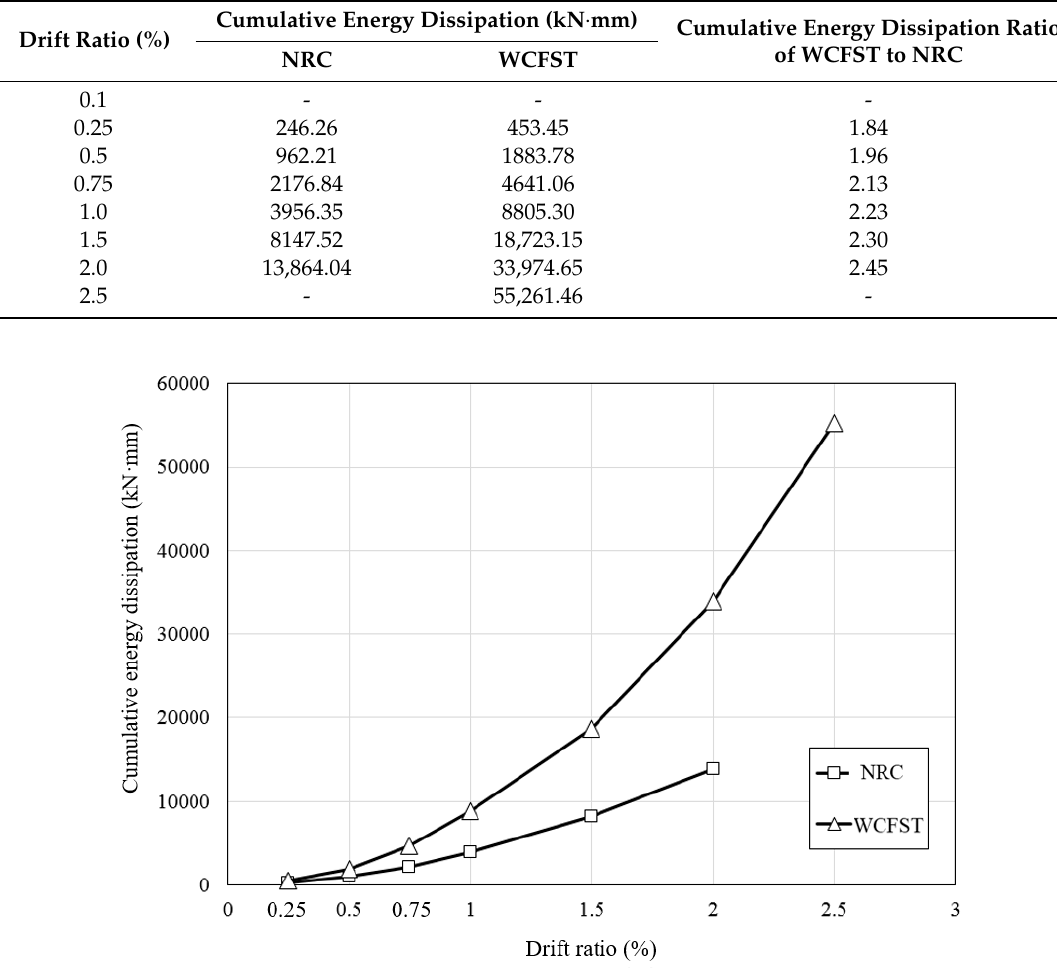
Figure 13. Cumulative energy dissipation from the specimens.